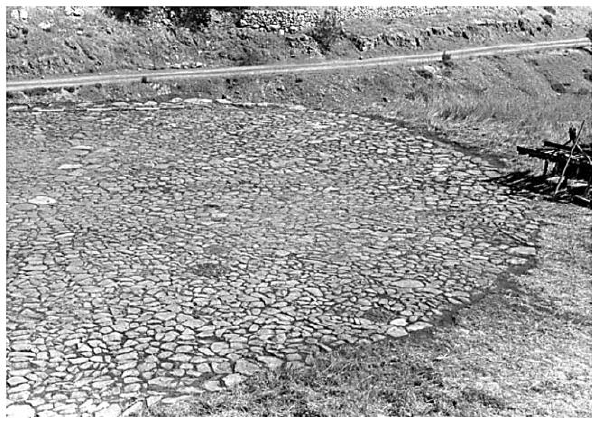
Figure 4. Abandoned twentieth-century threshing floor at Mitsero village, Cyprus (Given, 2014) The spatial identification of threshing floors was executed in ArcGIS. Every identified threshing floor was vectorized and its geometric, geographic and descriptive information was recorded in the database.